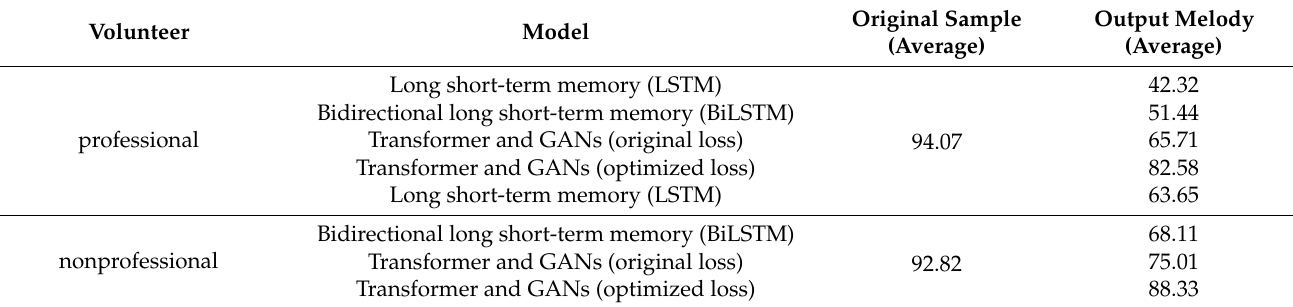
Table 5. Result of user